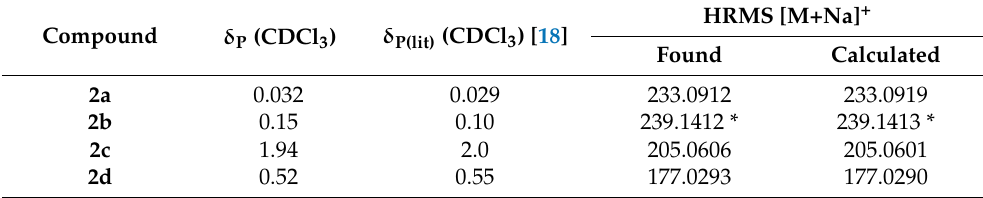
Table 6. Identification of dialkylphosphates ( 2a – d ).